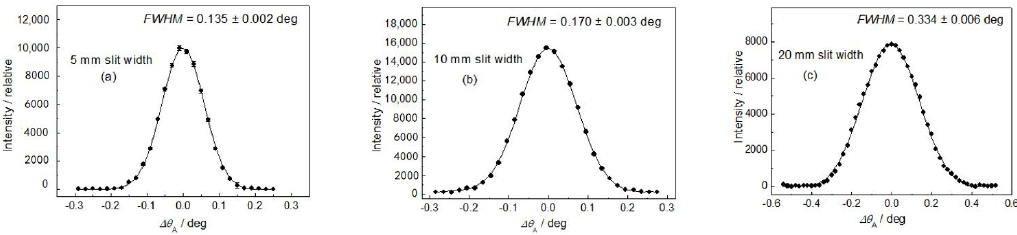
Figure 6. Rocking curves for the annealed α-Fe(110) low-carbon steel rod of ϕ = 8 mm in horizontal position: ( a ) 5, ( b ) 10, and ( c ) 20 mm Cd slits.